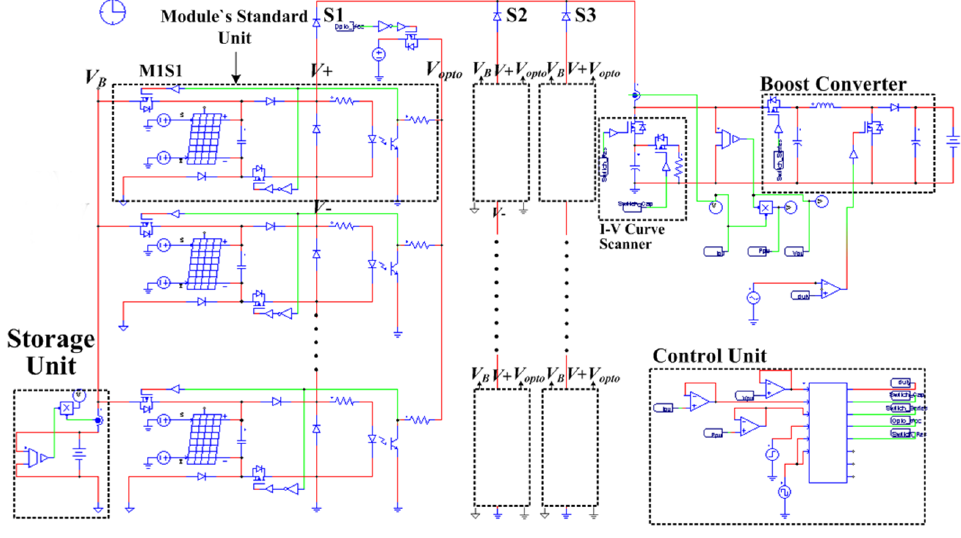
Figure 7. Simulation setup in PSIM .